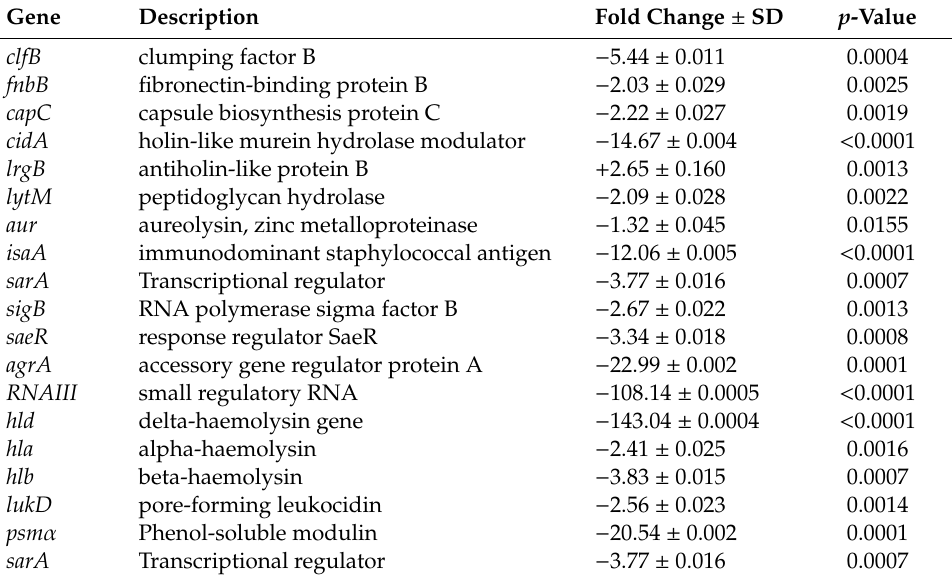
Table 1. RT-PCR analysis of biofilm gene expression in S. aureus ATCC 29213 in the presence of PYED-1. Gene Description Fold Change ± SD p -Value clfB clumping factor B − 5.44 ± 0.011 fibronectin-binding protein B capsule biosynthesis protein